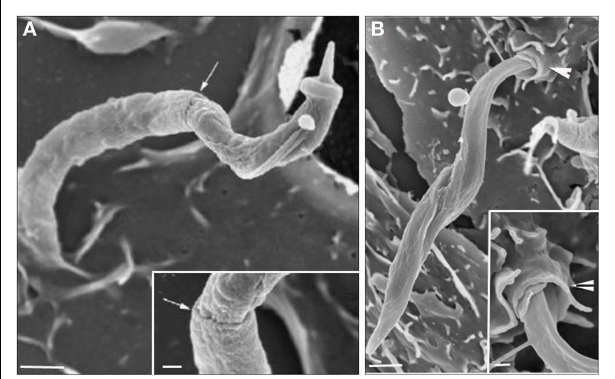
FIGURE 3 | Field emission scanning electron microscopy of the interaction between peritoneal macrophages and T. cruzi . (A) T. cruzi was partially tightly recovered by the macrophage plasma membrane (PM) in a process described as phagocytosis. (B) T. cruzi flagella recovered by host cell PM in a process described as coiled phagocytosis . Bars = 1 µ m [After Ref.